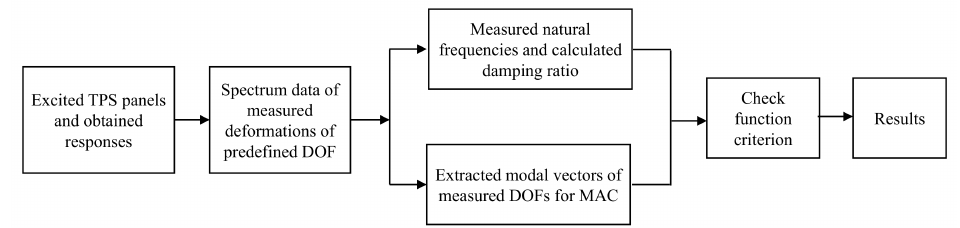
Figure 10. Flowchart of proposed damage detection using 3DPT and modal assurance criterion (MAC) method.